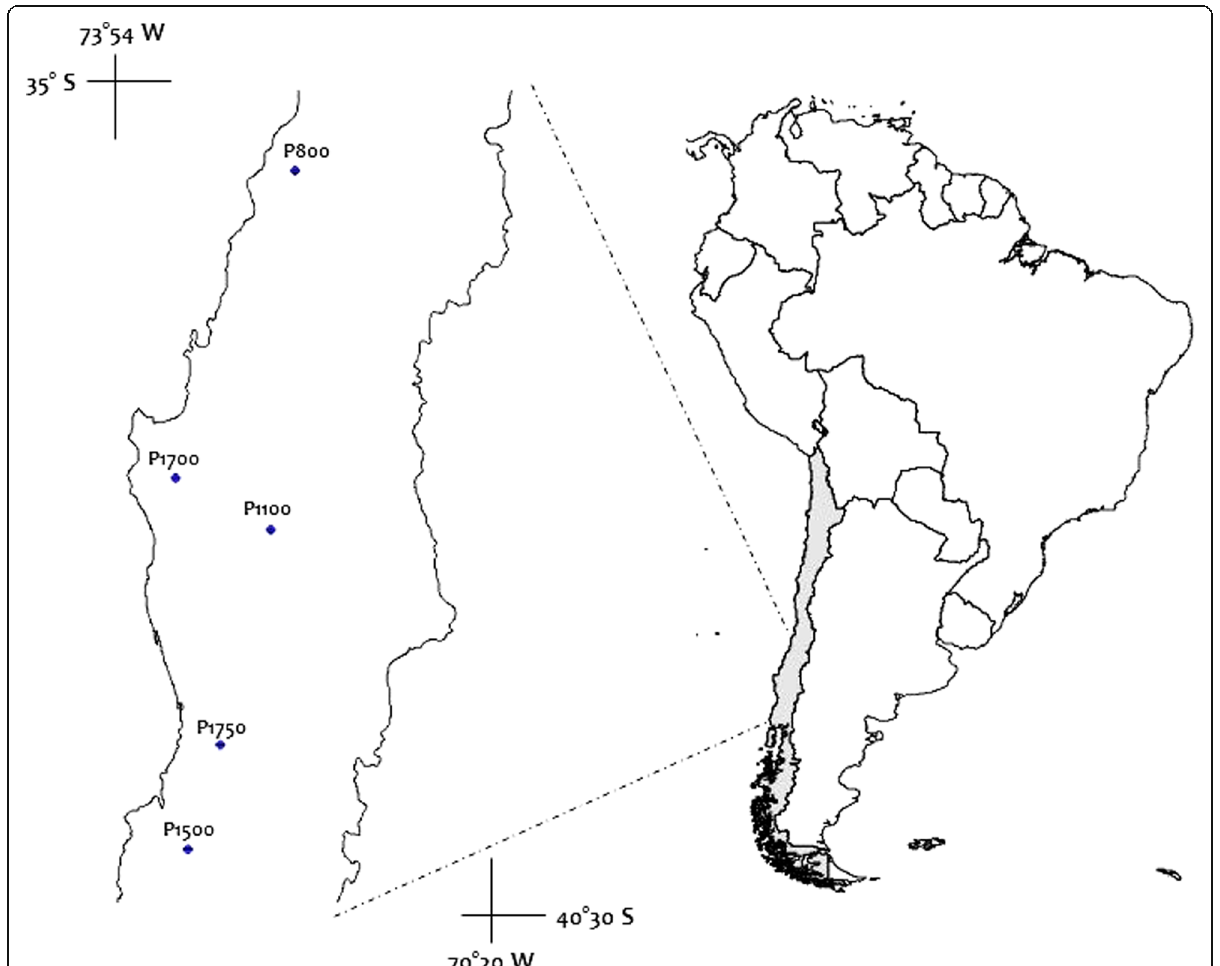
Fig. 1 Location of the study areas in central and southern-central